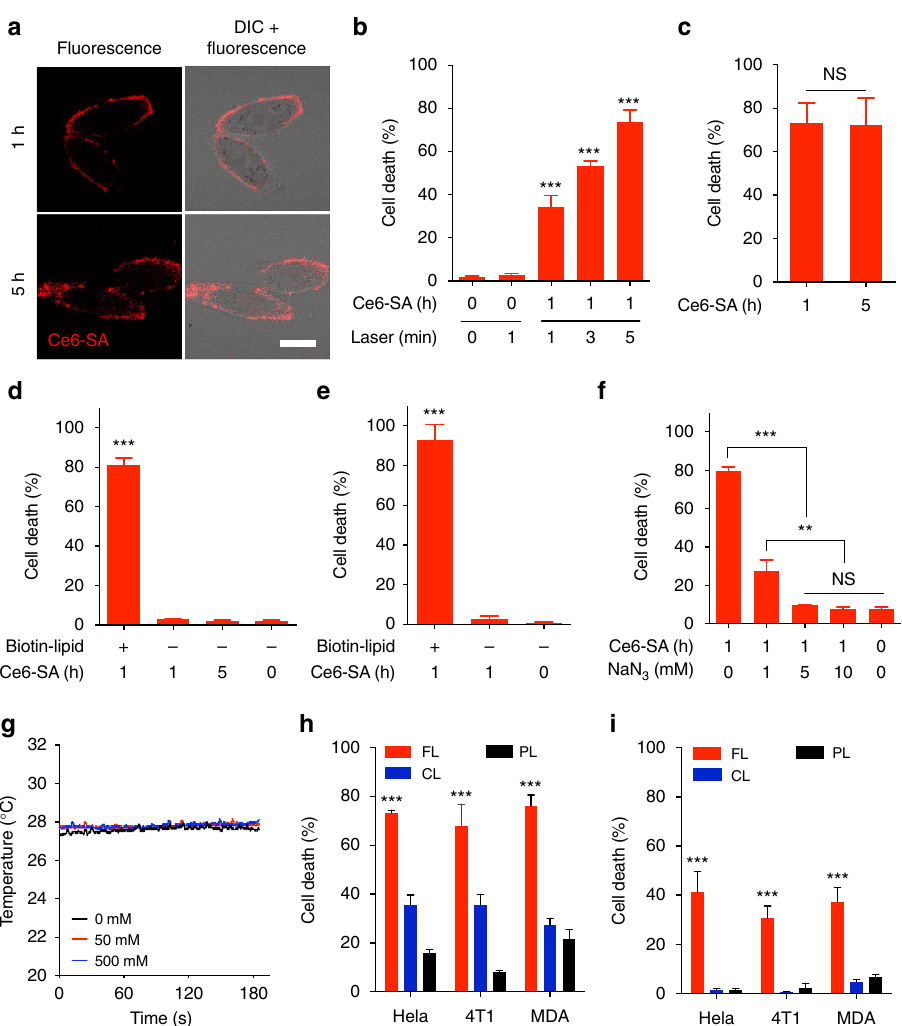
Figure 4 | Membrane-selective phototoxicity of tumour cells via cooperative membrane-targeted delivery. ( a ) Confocal fluorescent microscopic images of HeLa cells treated with Ce6-streptavidin (SA) for 1 or 5h after FL-mediated biotin-lipid delivery. Scale bar represents 20 m m. ( b ) Irradiation dose-dependent cell death after photodynamic therapy (PDT). HeLa cells were treated with Ce6-SA for 1h after FL-mediated biotin-lipid delivery, washed and then irradiated for PDT. ( c ) Incubation time-independent cell death after PDT. HeLa cells were treated with Ce6-SA for 1 or 5h after FL-mediated biotin-lipid delivery, washed and then irradiated for PDT. ( d ) FL-dependent cell death after PDT. Cells were treated with Ce6-SA for 1 or 5h directly or after FL-mediated biotin-lipid delivery, washed and then irradiated for PDT. ( e ) Phototoxic effect of free Ce6-SA in the media. Cells were treated with Ce6-SA for 1h directly or after FL-mediated biotin-lipid delivery and then irradiated for PDTwithout washing. ( f ) Reactive oxygen species-dependent cell death after PDT. Cells were treated with Ce6-SA for 1h after FL-mediated biotin-lipid delivery and washed. They were then treated with sodium azide (NaN 3 ) at different concentrations and irradiated for PDT. ( g ) Temperature change in the medium containing Ce6-SA at different concentrations during irradiation. ( h and i ) Phototoxicity of tumour cells [HeLa, 4T1 and MDA-MB-231(MDA)] in the upper transwell filter ( h ) and the lower chamber ( i ) treated with Ce6-SA 4h after biotin-lipid delivery to cells in the upper filter using various types of liposome. Data are means ± s.e.m. ( n ¼ 6 for b , n ¼ 5 for f , n ¼ 3 for c – e , h and i ; NS, not significant; *** P o 0.001, Student’s t -test for b – e , h and i ; ** P o 0.01, *** P o 0.001, one-way analysis of variance (ANOVA) with Tukey’s post hoc test for f 24h post-injection. In contrast, fluorophore-lipids delivered by PLs, which are the most common liposomal formulation for blood vessels, even at 24h post-injection. Uniform distribution